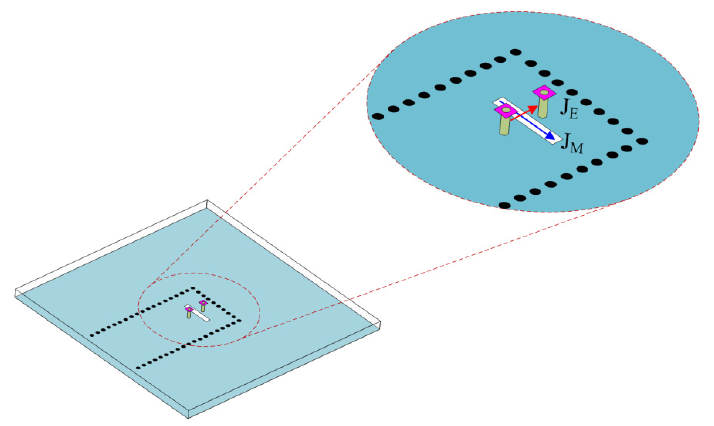
Figure 5. Operating principle of the SIW feed network with equivalent ME dipole.